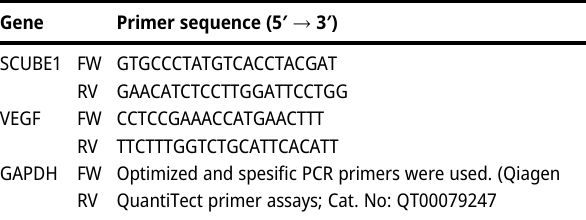
Table  : List of primers used for qRT-PCR. Gene Primer sequence (  ′ →  ′ ) SCUBE  FW GTGCCCTATGTCACCTACGAT RV GAACATCTCCTTGGATTCCTGG VEGF FW CCTCCGAAACCATGAACTTT RV TTCTTTGGTCTGCATTCACATT GAPDH FW Optimized and spesi fi c PCR primers were used. (Qiagen QuantiTect primer assays; Cat. No: QT  RV FW, forward primer; RV, reverse primer.